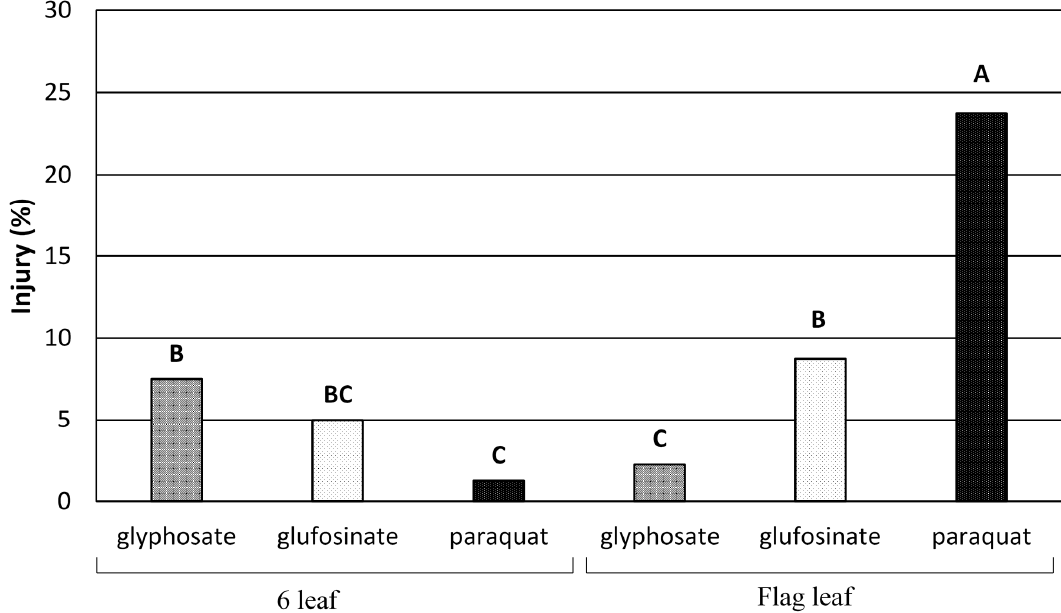
Figure 8. Grain sorghum injury from a simulated drift at 28 DAA as affected by the interaction of herbicides and application timing in 2018. Same letters on bars indicate no significant differences at p < 0.05, according to Fisher’s least significant difference test. drift caused 6% to 25% injury at different application timings, which might have resulted in poor